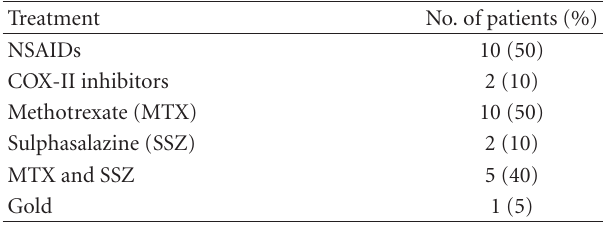
Table 2: Medications of the